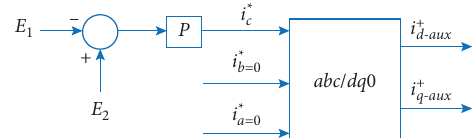
Figure 6: Te deviation suppression signal for DC-link capacitor voltage proposed in [17]. Table 2: Simulation parameters for